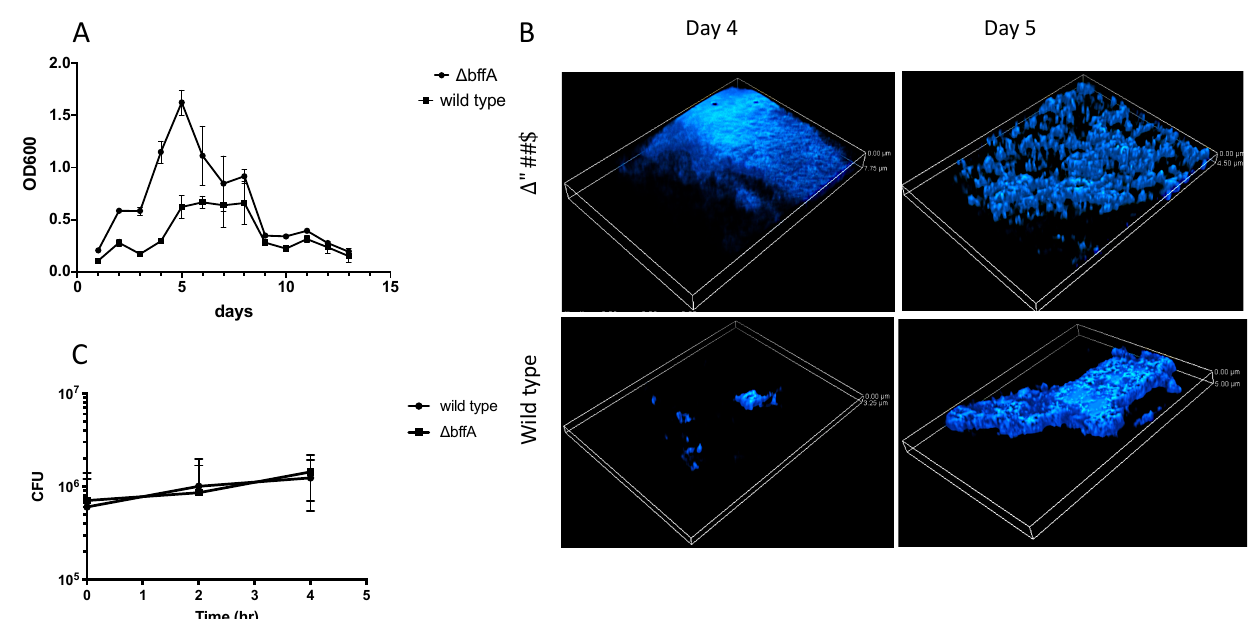
Figure 3. ∆ bffA forms biofilms faster than wild type . Biofilms grown in 96-well plates ( A ) and on glass coverslips and stained with DAPI ( B ). Binding assay ( C ) to test the ability of the bacteria to adhere to the 96-well plate. All experiments were repeated 3 times, with A and B a representative of each, and C the average of the three repetitions.